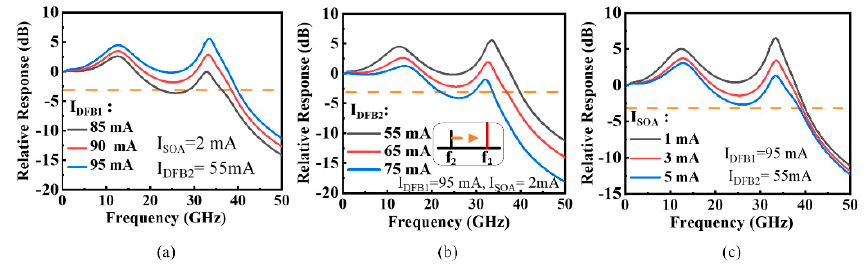
Figure 2. Simulated small-signal modulation response of the IMC laser with different ( a ) I DFB1 , ( b ) I DFB2 , and ( c ) I SOA values. Inset: schematic diagram of the variation of the detuning frequency as I DFB2 varied.